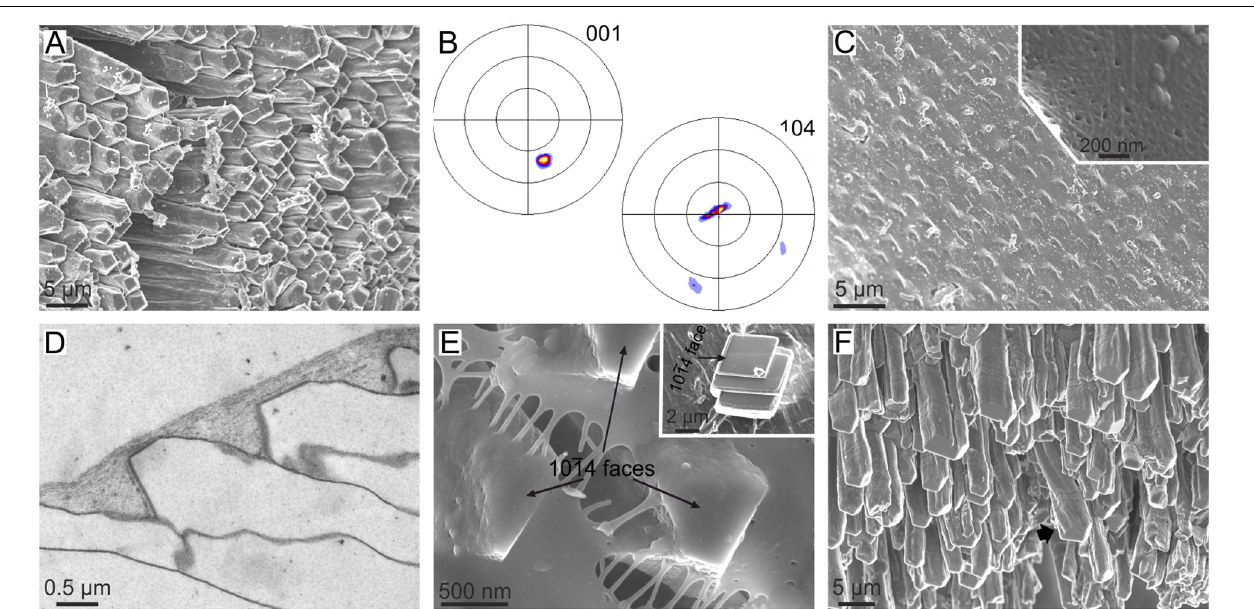
FIGURE 6 | The calcitic fibrous layer of mytilid bivalves and its relationship with the surface membrane. (A–E) Mytilus galloprovincialis . (A) Aspect of the growth surface of the fibrous layer. Note the even orientation of the 10 ¯ 14 faces (slightly darker in the image). (B) XRD pole figures of the fibrous layer seen from the growth surface. The orientation is similar to that in (A) , but the pole figures are rotated clockwise by ca. 70 ◦ . The pole figures reveal a sheet texture. (C) Outer aspect of the membrane, with the calcitic fibers slightly protruding from below the membrane. Inset, fibrous texture of the surface membrane. (D) TEM section along the axis of fibers and the surface membrane. The nanolaminated aspect of the latter is evident. (E) Detail of the tips of fibers. Their 10 ¯ 14 faces are perfectly cooriented, and one of them (the one looking toward the observer) is strictly parallel to the surface membrane. Inset, synthetic calcite crystal grown on the underside of an isolated surface membrane. It grows on a 10 ¯ 14 face. (F) Growth ends of the fibers of Bathymodiolus azoricus . Note the bending and twisting (arrow) fibers. (A–D,F) Modified from Checa et al.